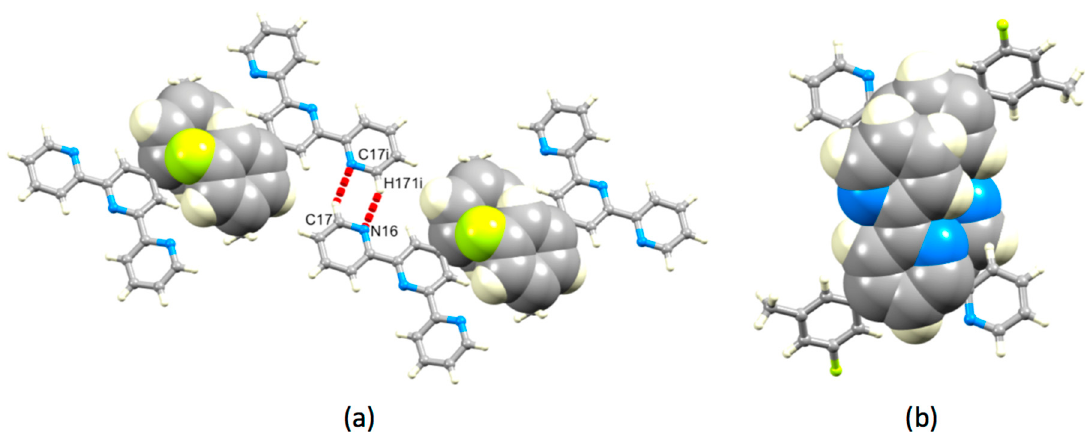
Figure 10. Packing interactions in 3 . ( a ) Hydrogen bonding between pairs of pyridine rings and π -stacking of 3-fluoro-5-methylphenyl (symmetry code i = − x , − 1 − y , 1 − z ), and ( b ) π -stacking of tpy domains.